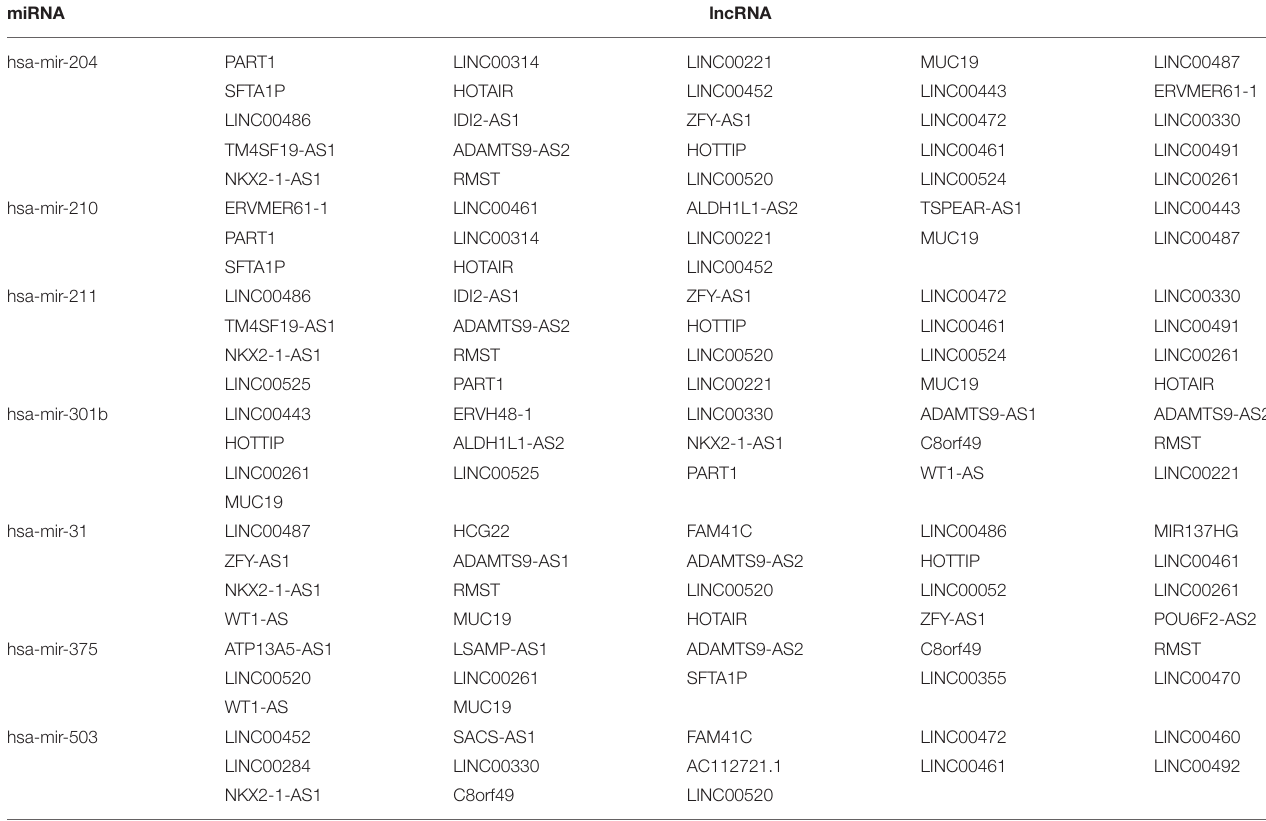
TABLE 4 | The miRcode database revealed interactions between DElncRNAs and DEmiRNAs.